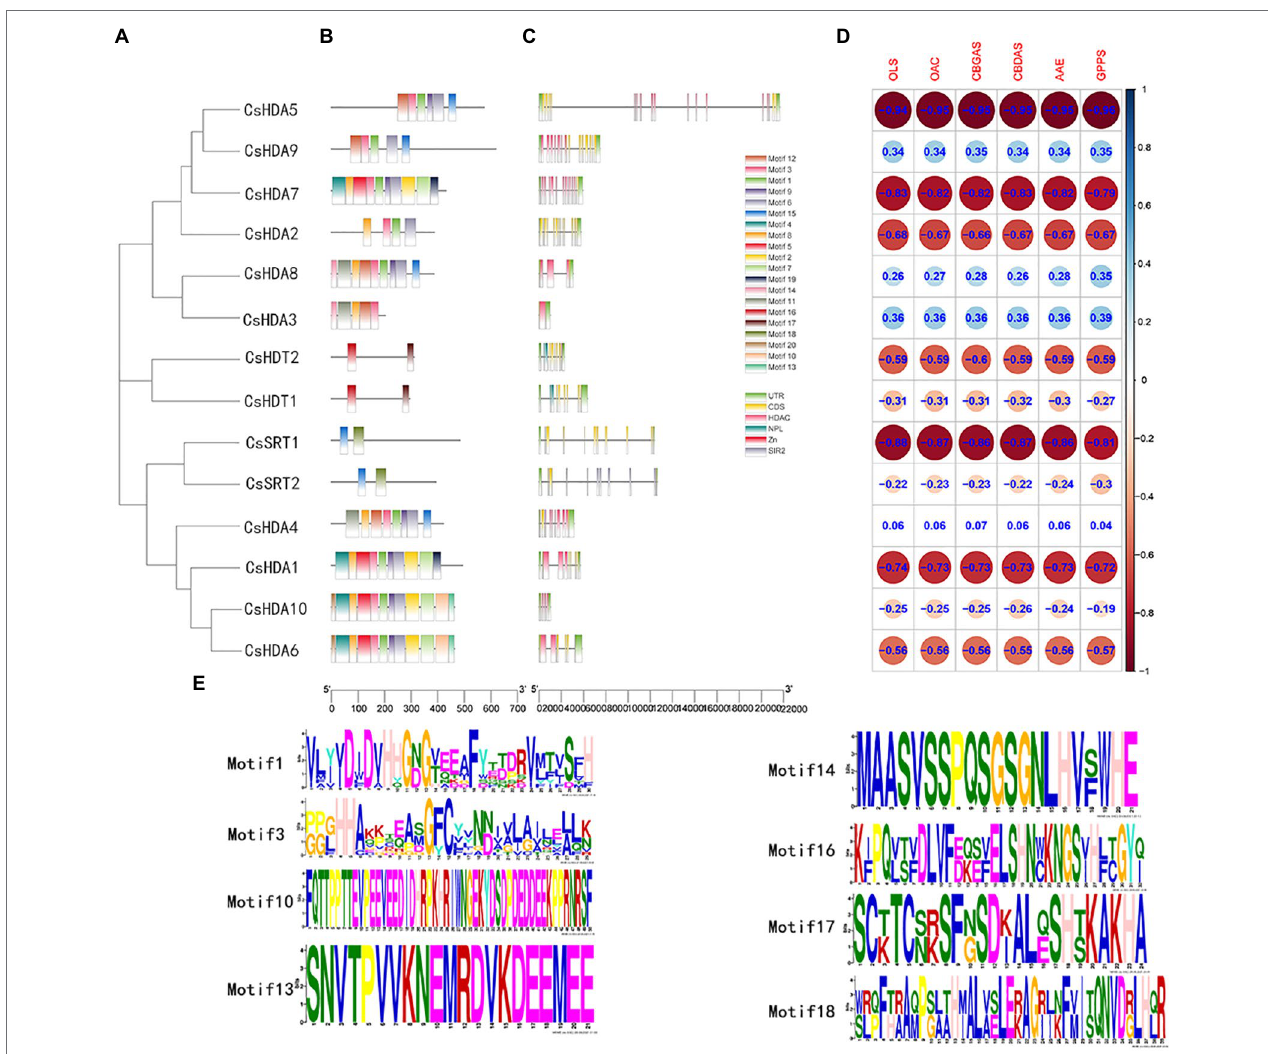
FIGURE 3 | The gene structures and the distribution of conserved motifs of CsHDACs. (A) Construction of phylogenetic tree based on the full-length sequence of CsHDAC protein. (B) The distribution of the motifs of each CsHDAC protein. (C) The gene structure and distribution of the conserved domains of CsHDACs. Green boxes, unrelated area; yellow boxes, exons; black lines, introns; pink boxes, HDAC domains; blue boxes; blue boxes, NPL domains; red box, zinc finger domain; and gray boxes, SIR2 domains. (D) Co-expression analysis of CsHDACs and key genes in the cannabinoid synthesis pathway. (E) The sequence information for representative